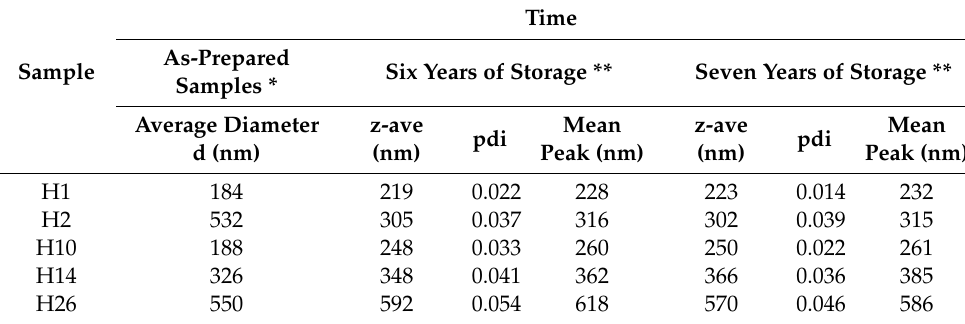
Table 2. Fluorinated methacrylate (HFMBA) samples studied by dynamic light scattering (DLS) after di ff erent sample exposure time.